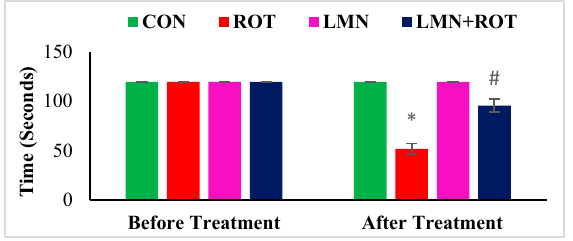
Figure 1. Rotarod test performance of rats. The values are presented as mean ± SEM. * p < 0.05 CON vs. ROT; # p < 0.05 ROT vs. LMN + ROT (one-way ANOVA followed by DMRT). CON: normal control, ROT: rotenone, LMN: limonene, LMN + ROT: limonene and rotenone treatment.